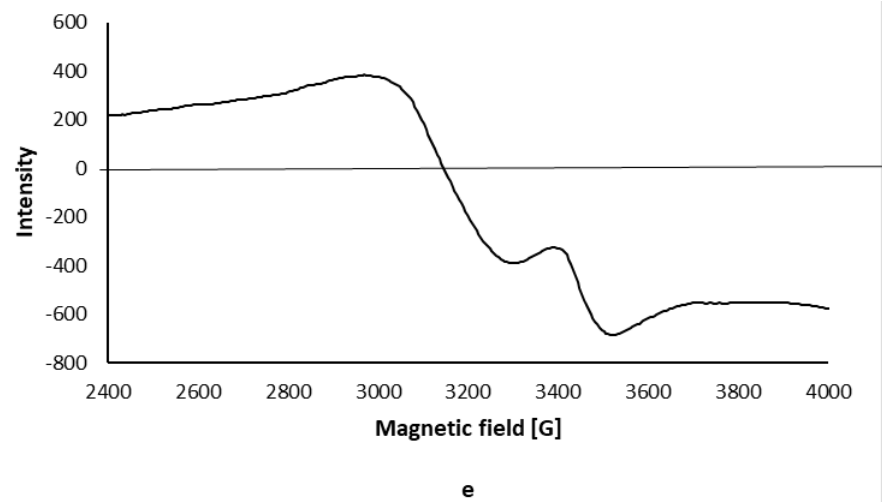
Figure 6. Electron Spin Resonance (ESR) spectra of deionized water saturated with nitrogen treated with GP for 5 ( a ), 15 ( b ), 30 ( c ), 60 ( d ) and 90 ( e ) min.